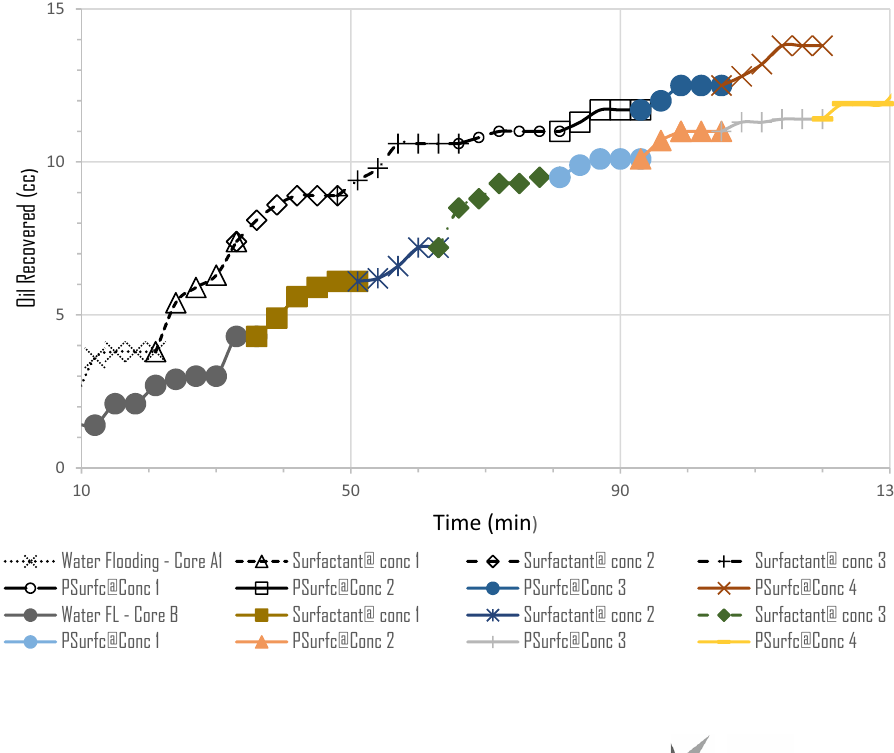
Fig. 10 Core flooding study comparison of water, surfactant and polymeric surfactant